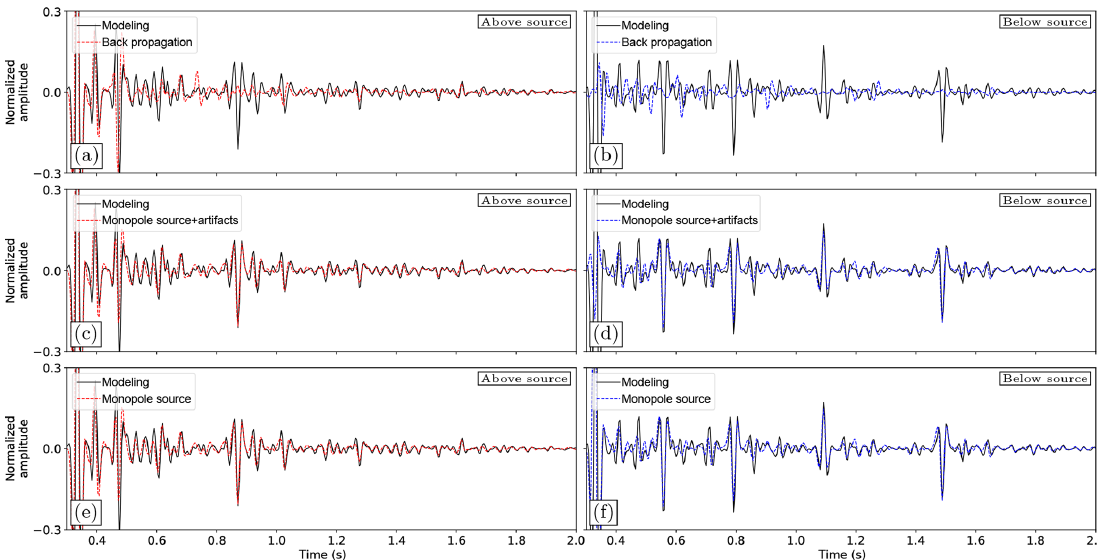
Figure 8. (a) Overlay of the traces from Fig. 7a and c. (b) Similar to (a) for the traces from Fig. 7b and d. (c) Similar to (a) for the traces from Fig. 7a and e. (d) Similar to (a) for the traces from Fig. 7b and f. (e) Similar to (a) for the traces from Fig. 7a and g. (f) Similar to (a) for the traces from Fig. 7b and h. All wave fields have been convolved with a 30Hz Ricker wavelet.